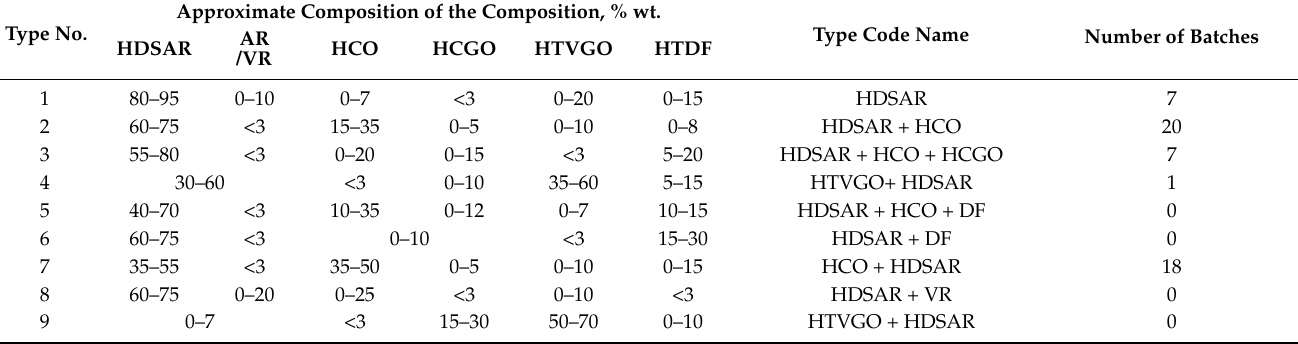
Table 16. Distribution of shipments of RME 180 from world ports by type (excluding the Middle East)